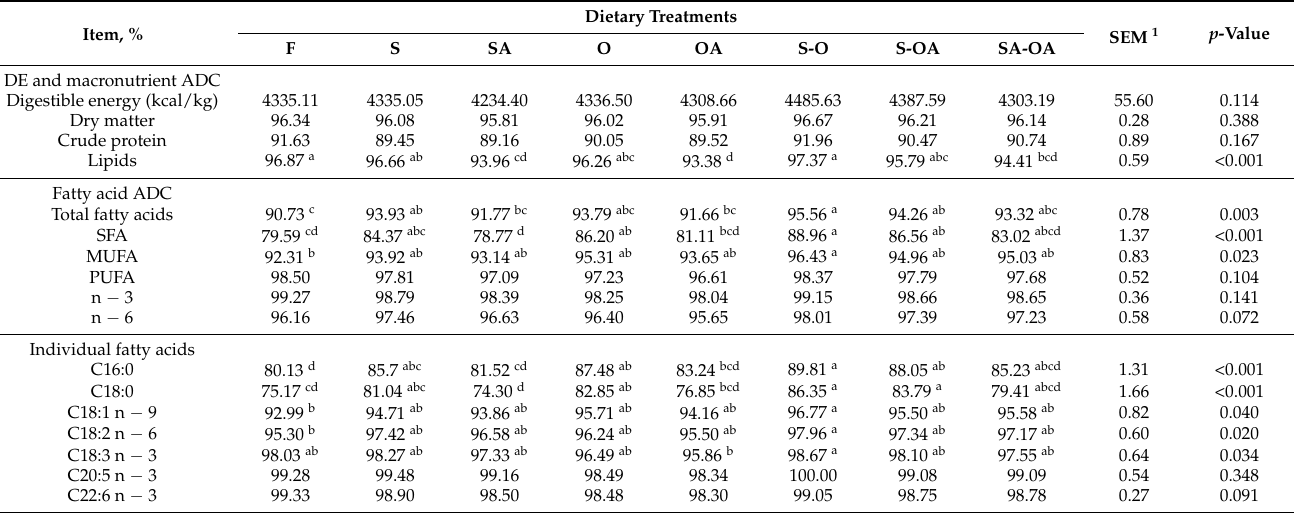
Table 5. Feed digestible energy, macronutrient and fatty acid apparent digestibility coefficients in European seabass fed different dietary fat